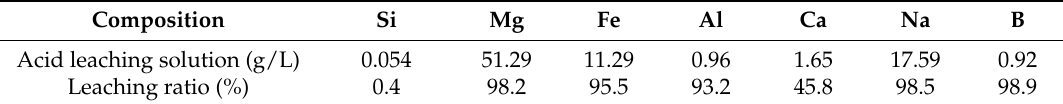
Table 3. Result of sulfuric acid leaching of MgO-enriched residue.